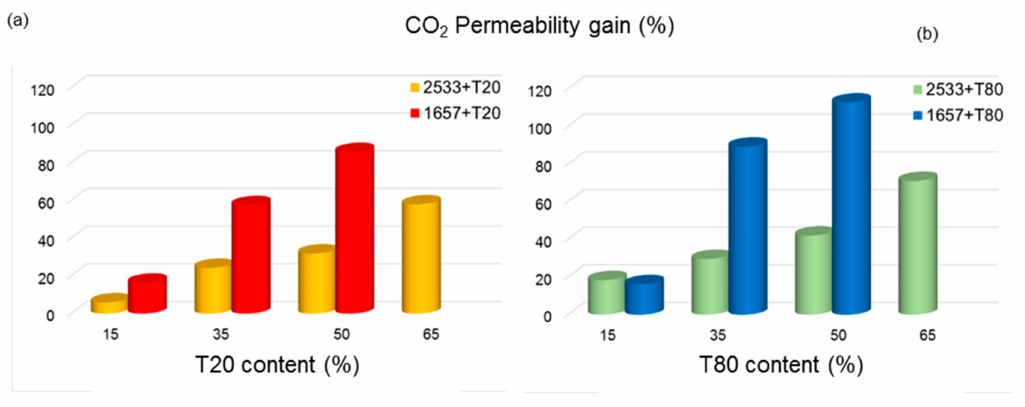
Figure 6. Permeability gain for CO 2 in the case of membranes doped with T20 ( a ) and T80 ( b ) with